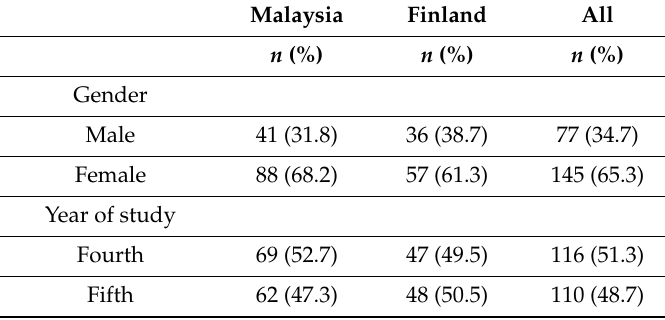
Table 1. The frequency and percentage distributions of gender, year of study, and perceived skills of dental students from Malaysia ( n = 131) and Finland ( n = 95).